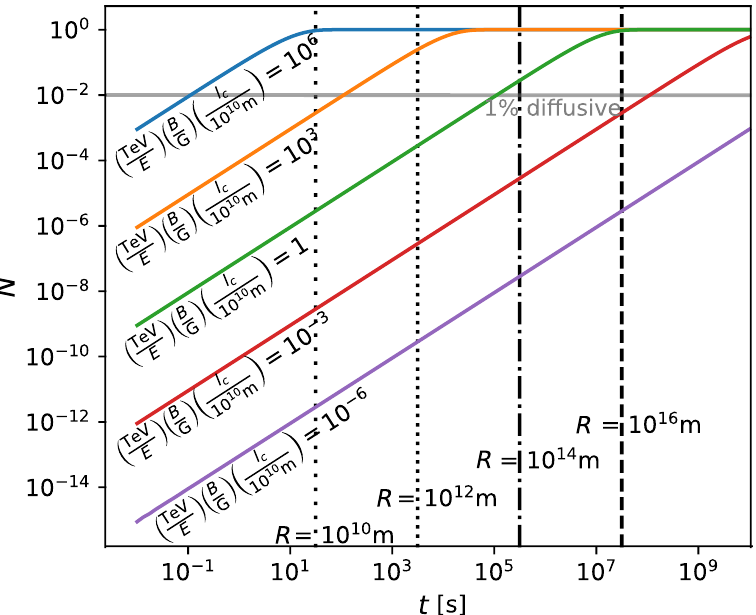
Figure 4. Fraction of particles, N , that are diffusive as a function of propagation time, t , for different blob parameters and particle energies. The vertical lines illustrate the time required for ballistic particle propagation to traverse the respective blob